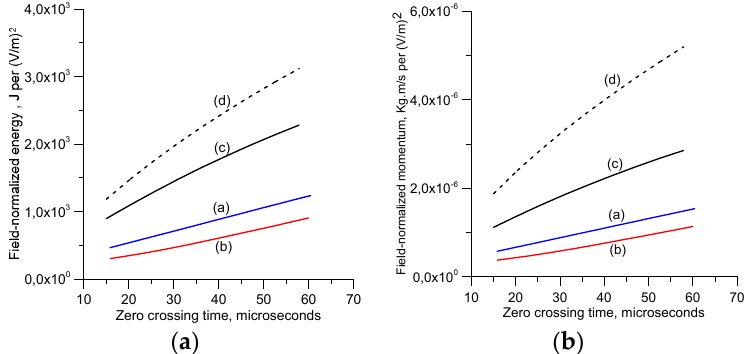
Figure 12. The field-normalized energy and momentum radiated by a subsequent return stroke simulated by the transmission line model. The peak channel base current is 12 kA. ( a ) Field-normalized energy. ( b ) Field-normalized momentum. (a) MTLL model; (b) MTLE model; (c) TL model with speed equal to 1.5 × 10 8 m/s; (d) TL model with speed equal to the speed of light.